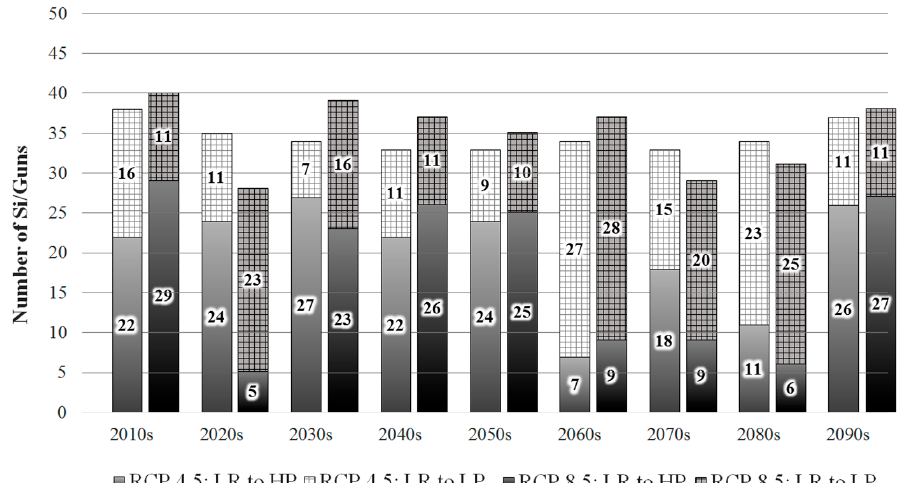
Figure 9. Comparison of changes in sensitivity types (LR to HP, HP to LR) with future climate change scenarios.